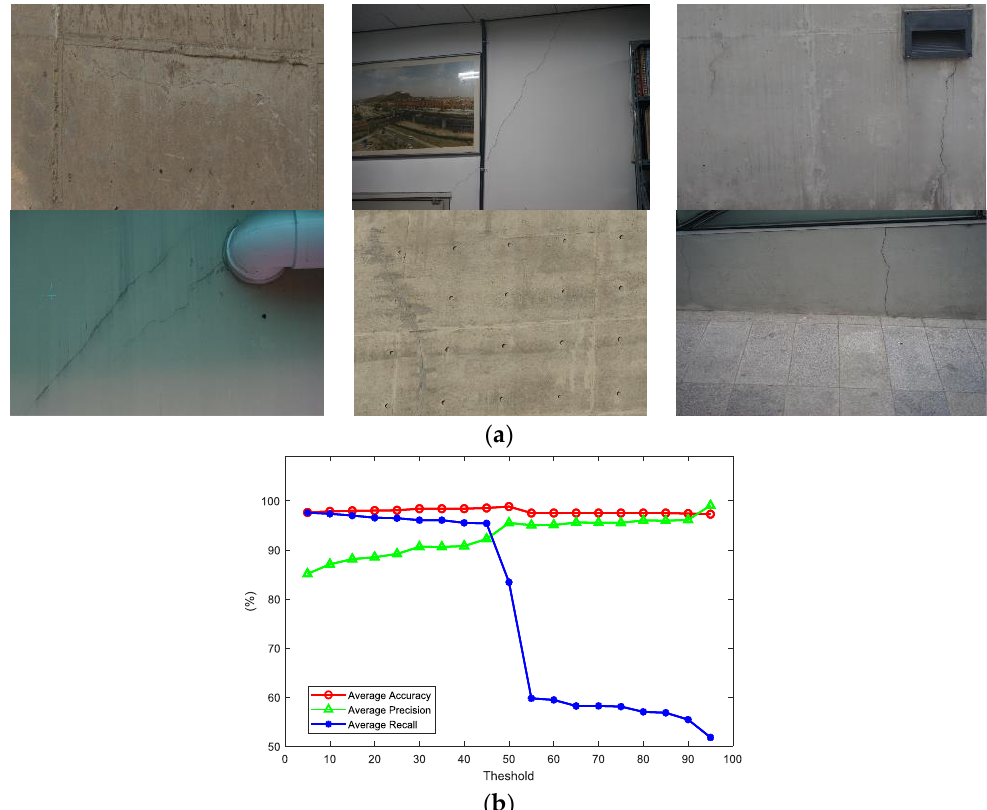
Figure 9. Parametric study of the probability threshold: ( a ) six crack images used for the parametric study; ( b ) performance measures of six images with increasing threshold.